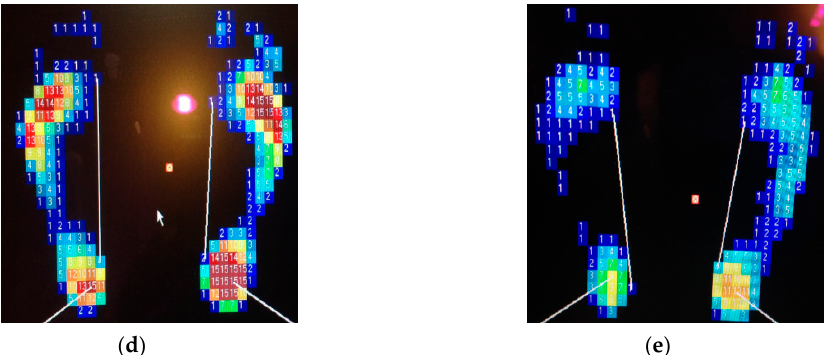
Figure 4. Foot plantar pressure distribution of participants: ( a ) No. 2; ( b ) No. 6; ( c ) No. 8; ( d ) No. 10; ( e ) No. 11, by i-Step P1000 digital pressure plate.